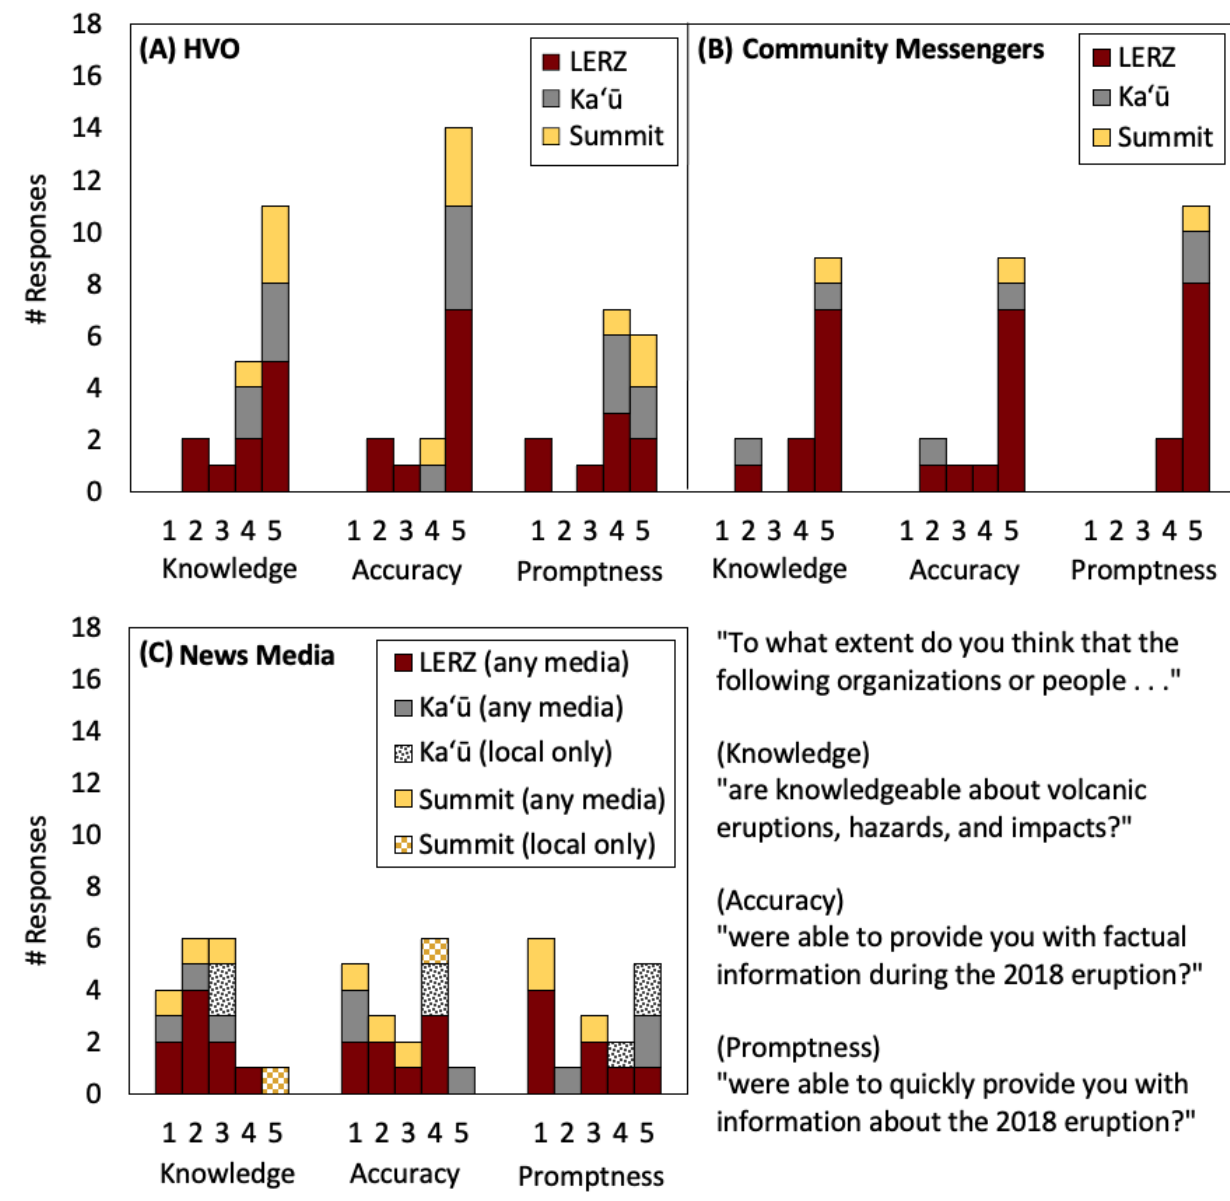
Figure 6: Participants’ stated opinions of each major source or messenger of eruption information: [A] U.S. Geological Survey Hawaiian Volcano Observatory (HVO), [B] community messengers, and [C] news media organizations. Each cluster of graphs plots participants’ Likert-type responses to the questions shown in the bottom right quadrant of the figure. Our Likert-type scale corresponds with the following qualitative descriptions: 1: "not at all," 2: “not much,” 3: “fair,” 4: “great,” 5: "very great." Gray- speckled and yellow-checkered bars in [C] are responses from Ka ‘ ¯u and summit participants, respectively, who emphasized local news media throughout their interview